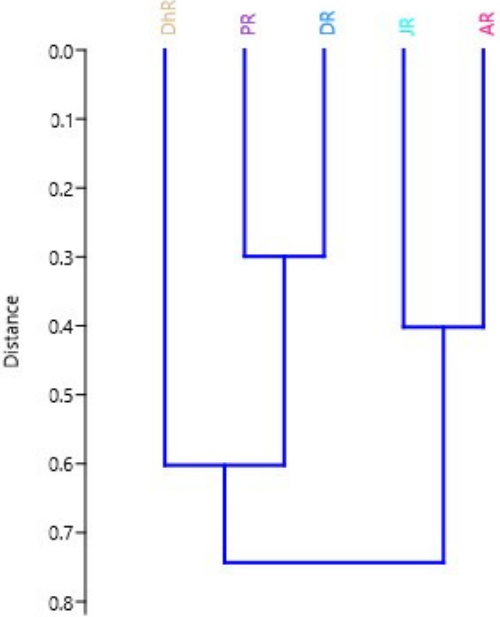
Figure 5. Dendrogram from morphometric measurements and ratios derived from UPGMA cluster analysis based on the Euclidean distance between the species centroids. In the figure, stocks areas are shortened as JR, Jamuna River; AR, Atrai River; DhR, Dhorala River; DR, Danu River, and PR, Padma River.